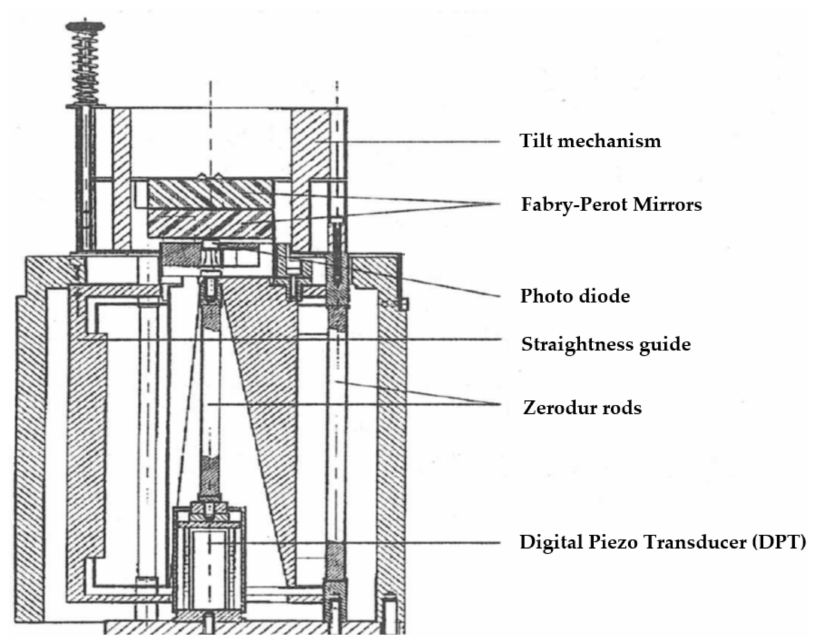
Figure 9. Sketch of a calibration system based on a digital piezo transducer, calibrated by a Fabry–P é rot